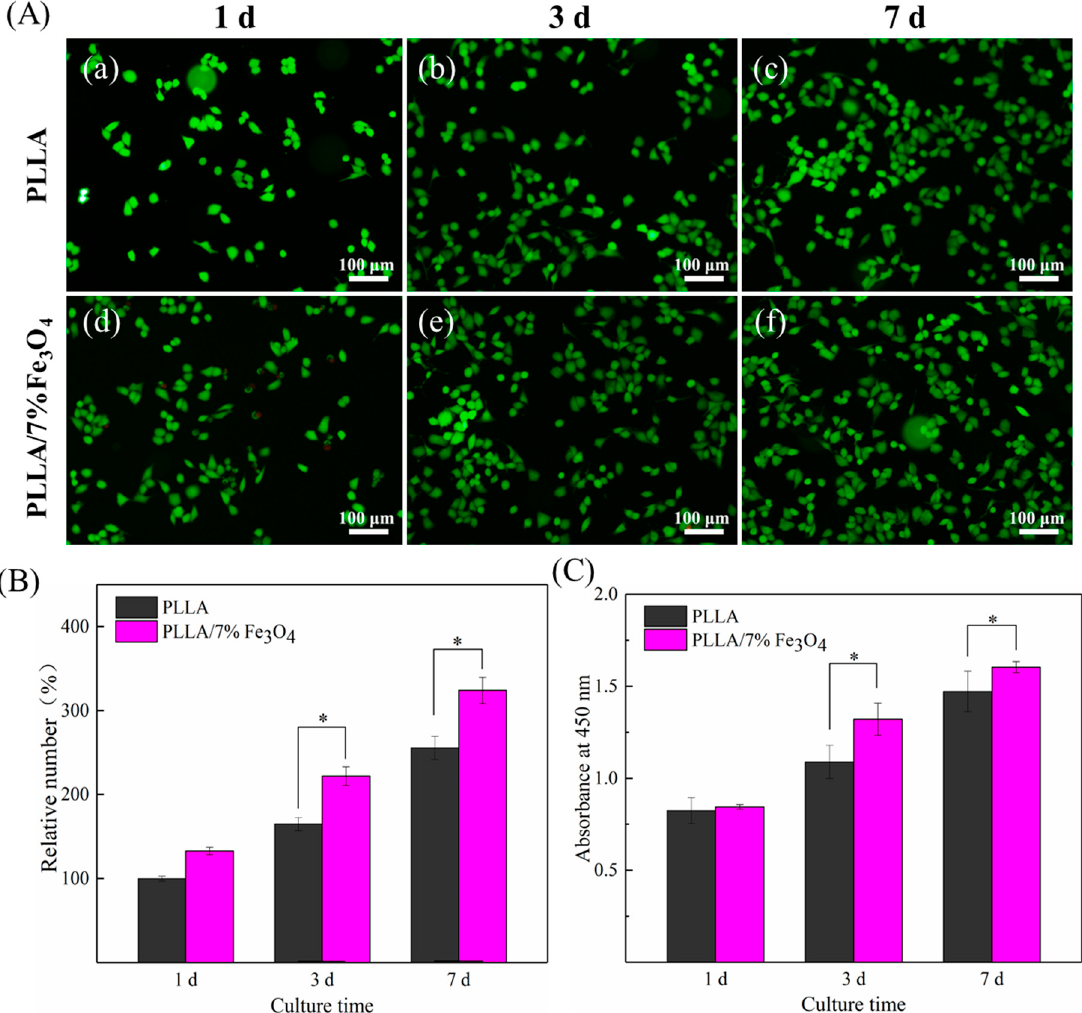
Figure 7. ( A ) Fluorescence image of MG63 cell culture on the scaffolds for 1, 3 and 7 days. ( a ) 1 day on the PLLA scaffold, ( b ) 3 days on the PLLA scaffold, ( c ) 7 days on the PLLA scaffold, ( d ) 1 day on the PLLA/7%Fe 3 O 4 scaffold, ( e ) 3 days on the PLLA/7%Fe 3 O 4 scaffold, ( f ) 7 days on the PLLA/7%Fe 3 O 4 scaffold. ( B ) The relative number of living cells in the fluorescence graph. ( C ) CCK-8 graph.